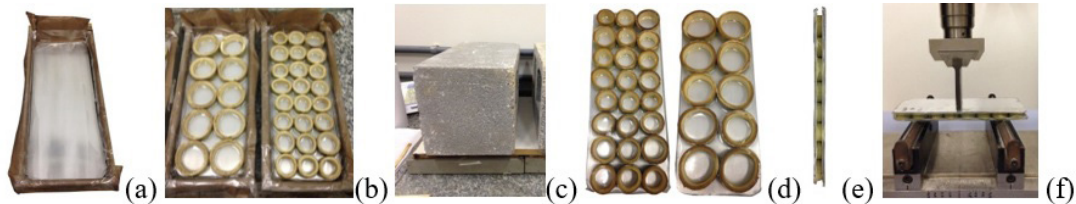
Figure 3. Manufacturing steps: (a) mould preparation, (b) bamboo ring insertion, (c) cold compaction, (d) second layer bonding, (e) sandwich panel and (f) bending